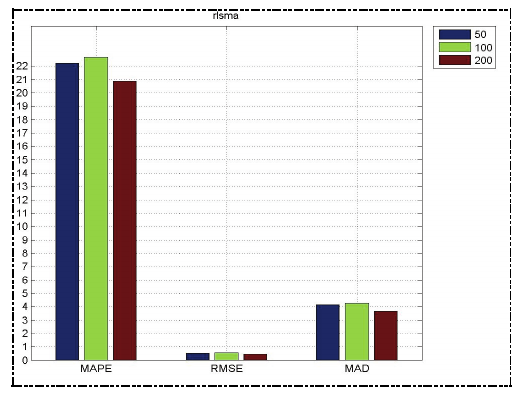
Fig.6. Performance evaluation graph of MAPE, RMSE and MAD values of various hidden layers in proposed technique for dataset 1